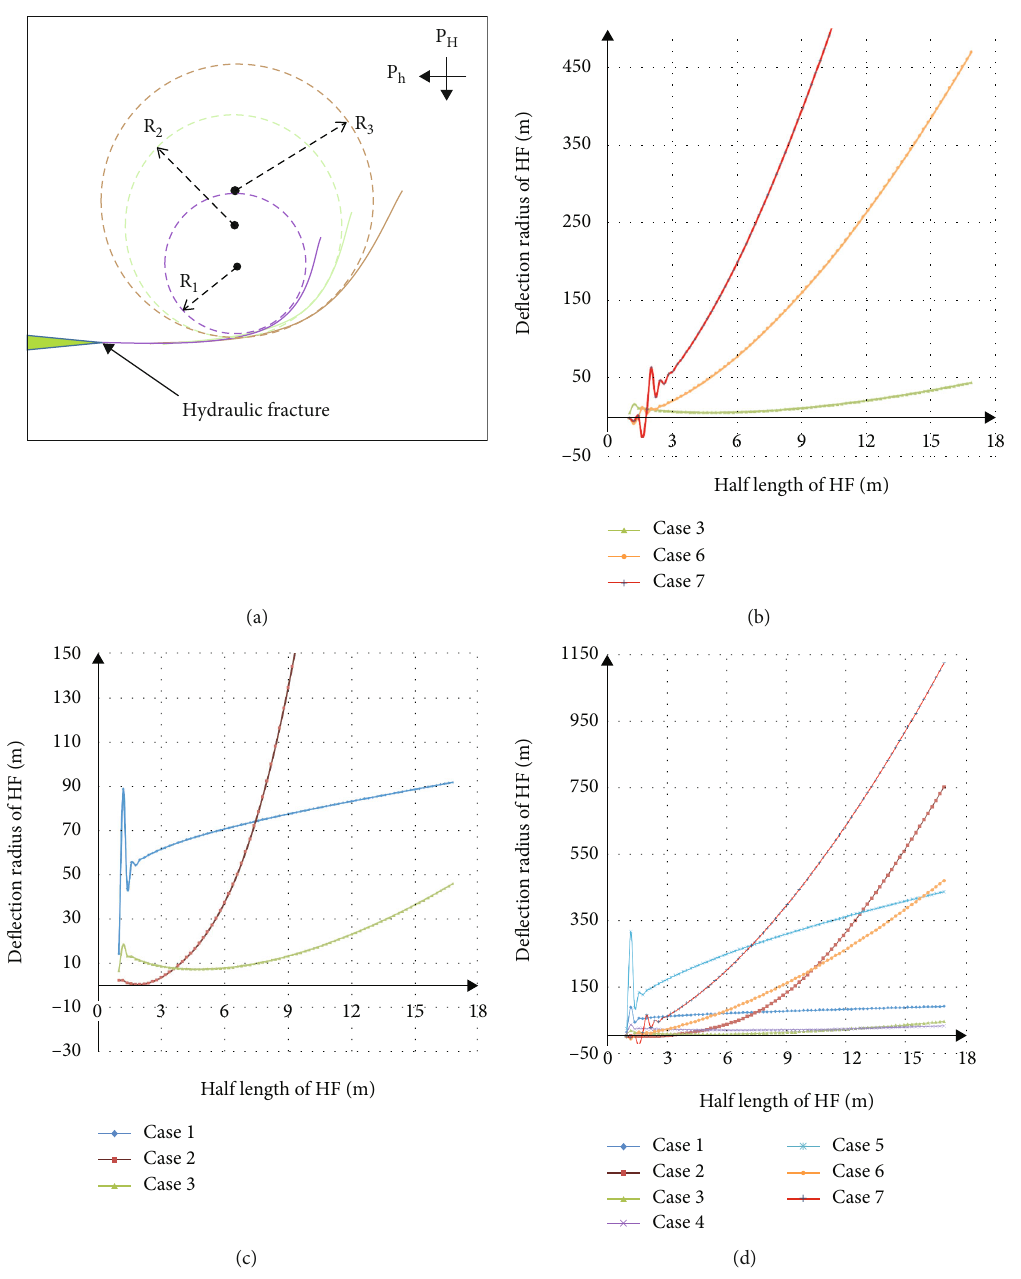
Figure 6: The fracture curvature radius. (a) The physical model. R radius of HF with di ff erent perforation angles. (c) Curvature radius of HF with di ff erent stress di ff erences. (d) Curvature radius of HF from cases 1 to